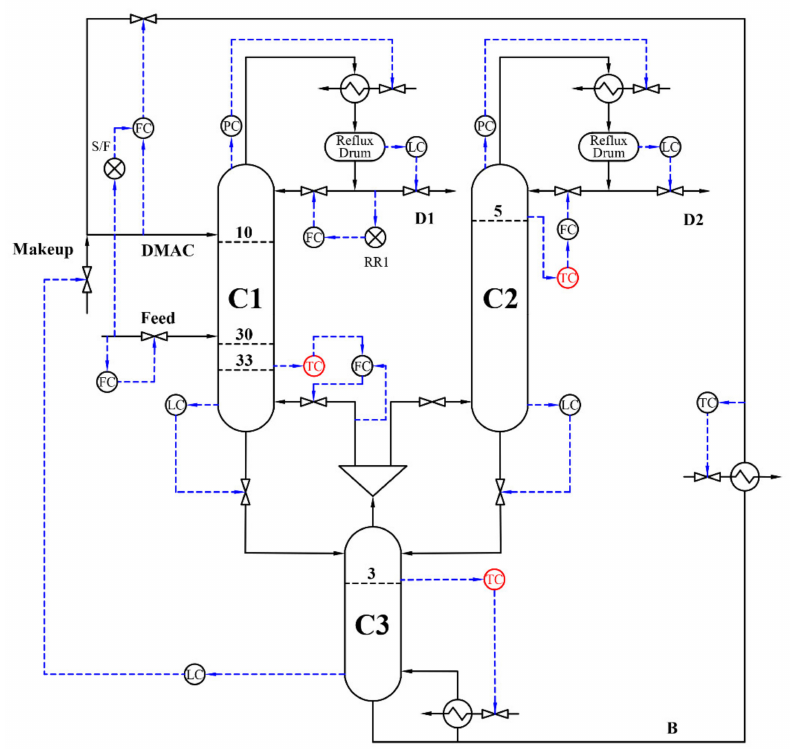
Figure 13. Control structure